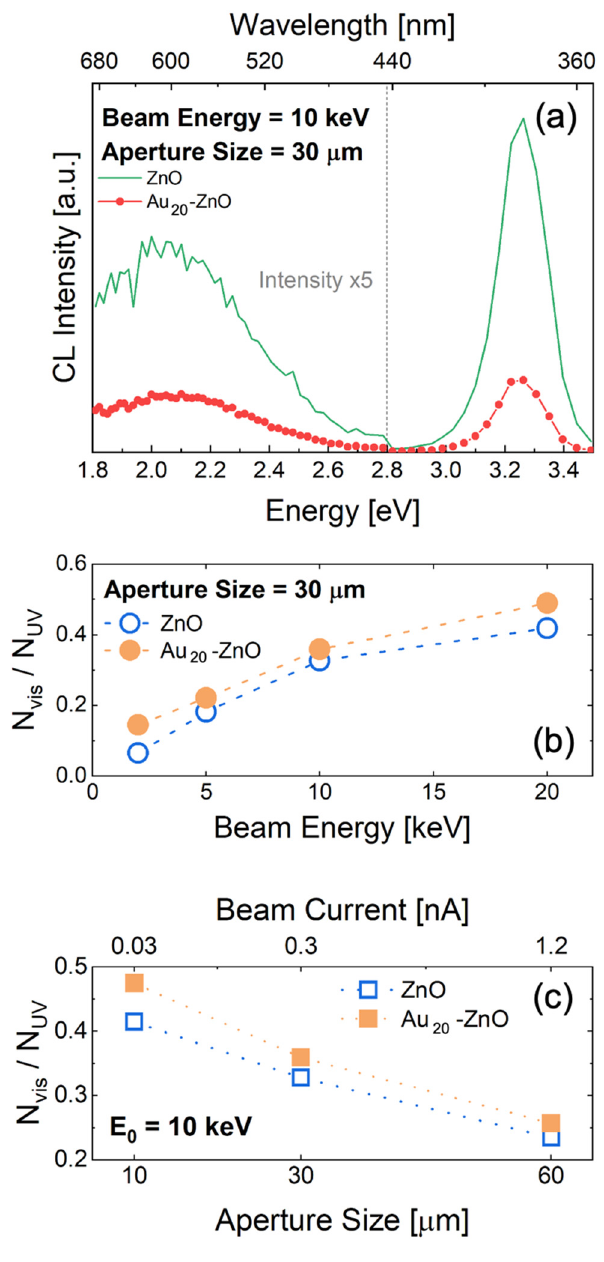
Figure 3. ( a ) CL spectra of bare ZnO (green) and Au 20 -ZnO (red), with visible emission multiplied by a factor of 5; ratio between the intensity of visible ( N vis ) and UV emission ( N UV ) as a function of the electron beam energy ( b ) and current ( c ).